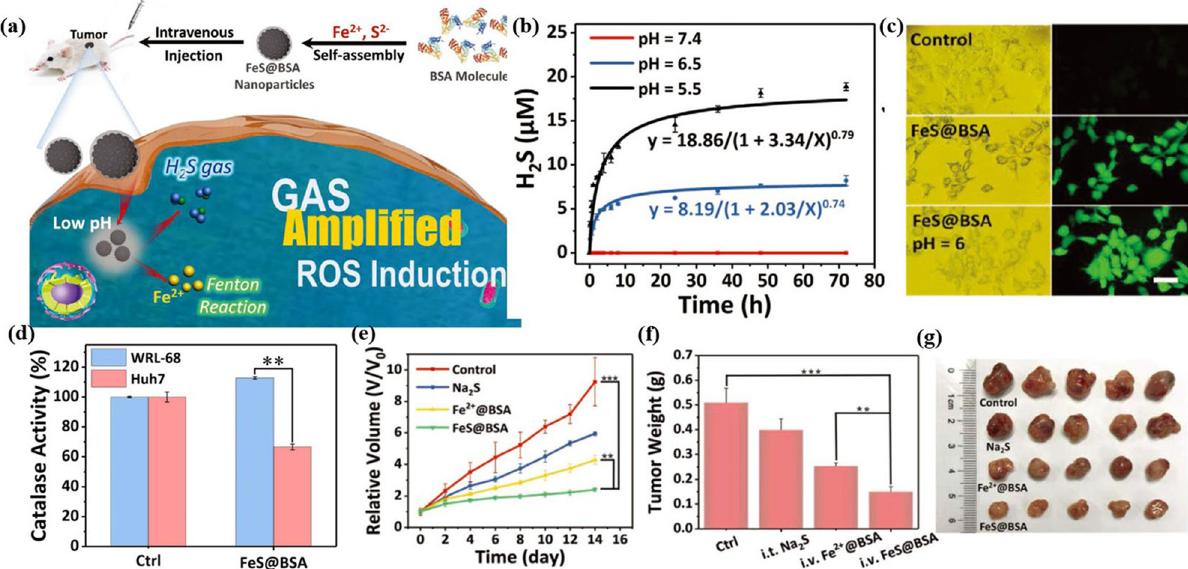
Figure 3: ( a ) Schematic illustration of the synthesis of FeS@BSA nanoparticles. ( b ) H 2 S releasing pro fi le at pH 7.4, 6.5, and 5.5. ( c ) Fluorescent images of DCFH - DA - stained Huh7 cells incubated with 20 µg mL − 1 of FeS@BSA in neutral and acidic ( pH = 6 ) medium for 6 h, showing intracellular ROS. The untreated cells were used as the control group. ( d ) The e ff ect of H 2 S from FeS@BSA ( 0.1 mg mL − 1 ) on catalase activity of WRL - 68 and Huh7 cells. ( e and f ) Relative tumor volumes and tumor weights after di ff erent treatments. ( g ) Photograph of the tumors from each treatment group. Reprinted with permission from ref. [ 34 ] ; Copyright © 2020 Wiley -